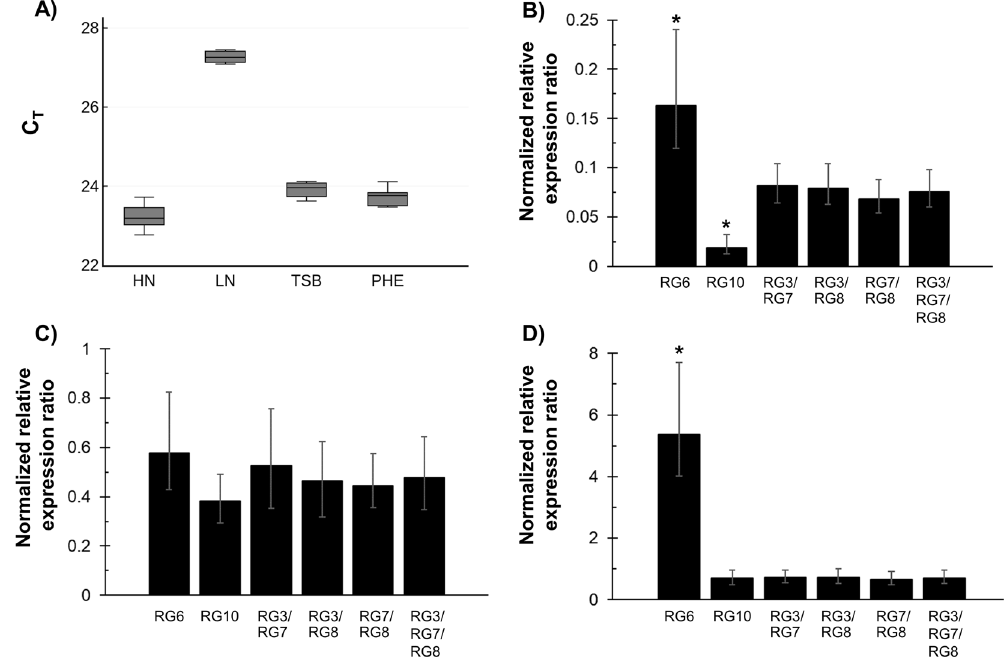
Figure 5. Effect of reference gene choice on RT-qPCR normalization. ( A ) Box plots of averaged PD630_ RS15810 expression data (C T ) for all four growth conditions (HN, LN, TSB, and PHE). Each gray box represents the first through third quartiles, the solid black line represents the median, and the whiskers represent the minimum and maximum values. ( B – D ) The normalized relative expression ratio of PD630_LPD05540 going from HN to either LN ( B ), TSB ( C ), or PHE ( D ). The expression data was normalized with a NF, including RG6, RG10, RG3/RG7, RG3/RG8, RG7/RG8, and RG3/RG7/RG8 using REST 2009. Error bars represent the 95% confidence interval (CI) as calculated by REST 2009. Stars indicate that a 95% CI range falls outside of the 95% CI range of the RG3/RG7/RG8 (and RG7/RG8) normalized